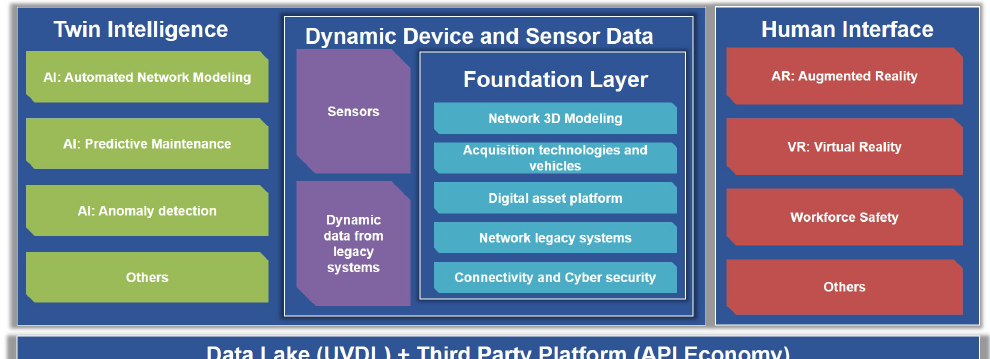
Figure 2. NDT© layers developed during the UF